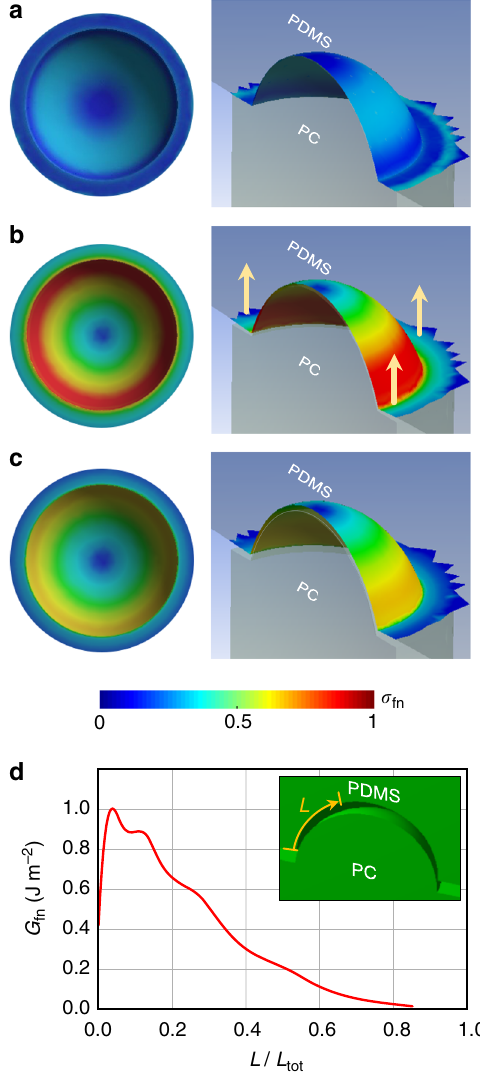
Fig. 6 Computational analysis of demolding-induced friction. a – c The distribution of the frictional stress computed by nonlinear FEA. The left and right columns represent the top and cross-sectioned bird ’ s eye views of a PDMS nanocup getting demolded from a PC nanocone, respectively. The color indicates σ fn , the frictional stress normalized by its overall maximum. a , b , c Describe the PDMS nanocups in conformal contact with the PC nanocone, at the initial stage of the vertical demolding (along the direction indicated by the arrows), and at the starting point of the peel-off, respectively. The latter two clearly show that the demolding action induces the highest level of frictional stress around the nanocup ’ s rim. d G fn , the frictional fracture energy normalized to its maximum, as a function of L / L tot . It further con fi rms that the frictional stress accumulated over the whole- demolding process maximizes around the rim. G fn exhibits a sharp peak up to L ~ 0.2 L tot (~60 nm in our setup) before a rapid decay, in good agreement with our electrostatic modeling result, which indicated that the surface charges form a 55 nm-wide band from the